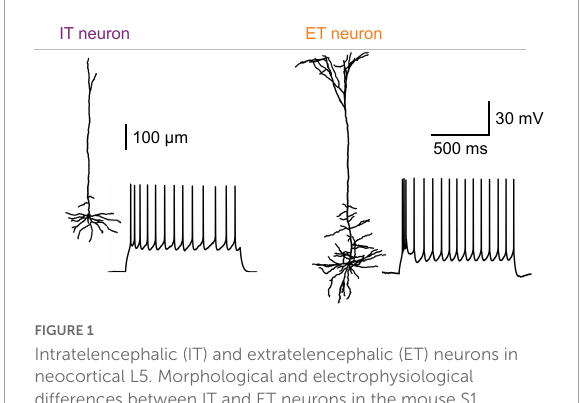
FIGURE1 Intratelencephalic (IT) and extratelencephalic (ET) neurons in neocortical L5. Morphological and electrophysiological differences between IT and ET neurons in the mouse S1. Adapted from Takahashi et al.